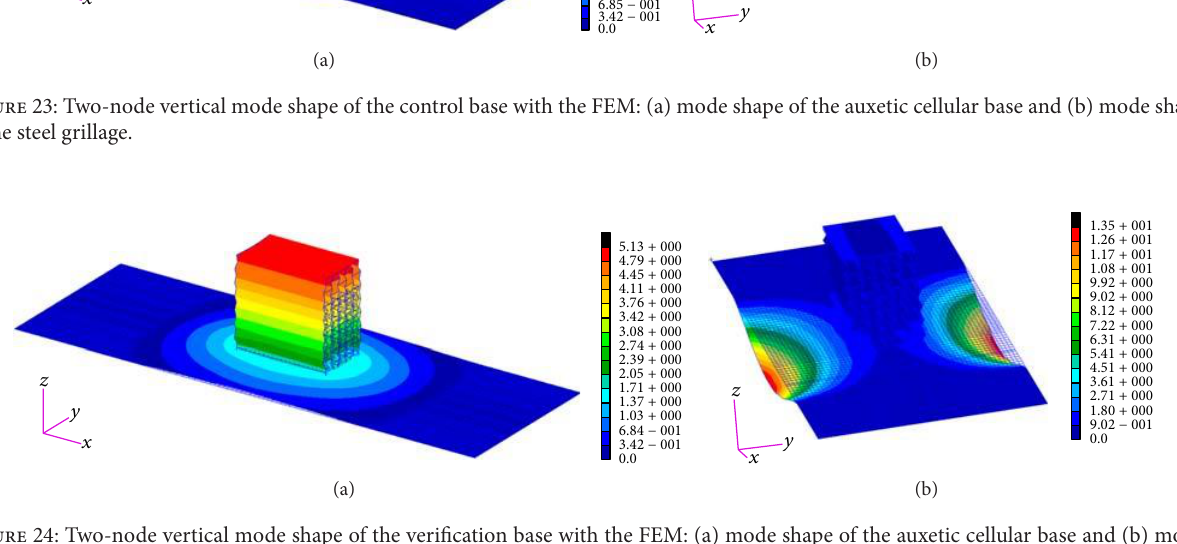
Figure 24: Two-node vertical mode shape of the verification base with the FEM: (a) mode shape of the auxetic cellular base and (b) mode shape of the steel grillage.